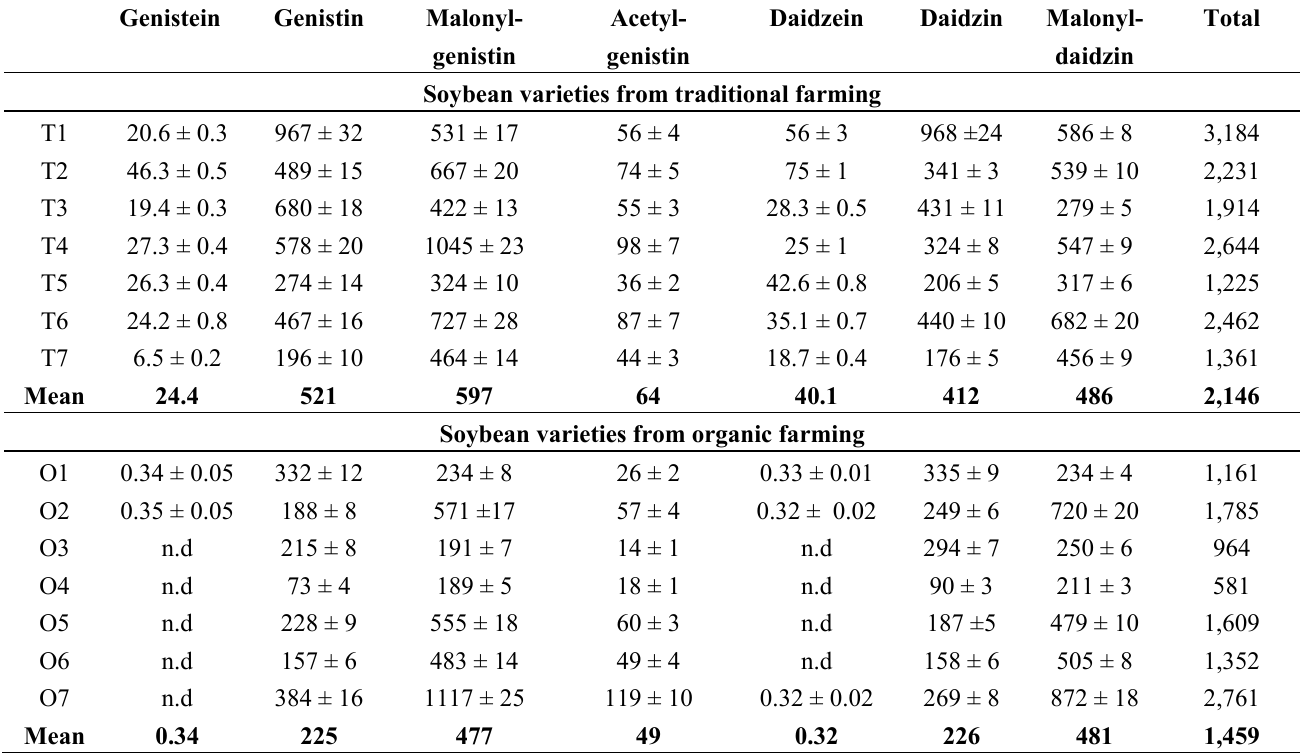
Table 3. Quantity (mg/kg of fresh soybean) of isoflavones in soybean varieties (1–7), determined by 1H